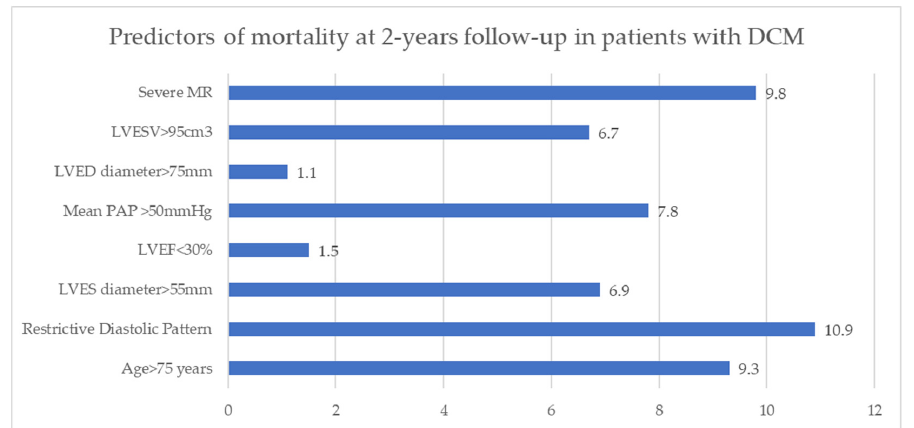
Figure 2. Predictors of mortality at 2-years follow-up in patients with DCM. MR—mitral regurgitation; LVESV—left ventricle end-systolic volume; LVEDD—left ventricle end-diastolic diameter; LVEDV—left ventricle end diastolic volume; LVESV—left ventricle end systolic volume PAP—pulmonary arterial pressure Regarding the patients’ clinical course, the percentages of those with a favorable evo- lution quantified as NYHA class of HF less than 3 and self-reported quality of life score more than five at one- and two-years follow-up were higher in the nonrestrictive LVDFP group. At 1-year follow-up, the percentage of patients with a better or the same quality- of-life score was significantly higher in nonrestrictive LVDFP subgroup of patients com- pared with the restrictive one (58.13% vs. 13.04%, p < 0.005, likelihood ratio). Also, at 1- year follow-up, the percentage of patients in NYHA class less than 3 was four-fold in pa- tients with nonrestrictive LVDFP (42.1% in nonrestrictive LVDFP group vs. 10.52% in re- strictive LVDFP group, p < 0.05).